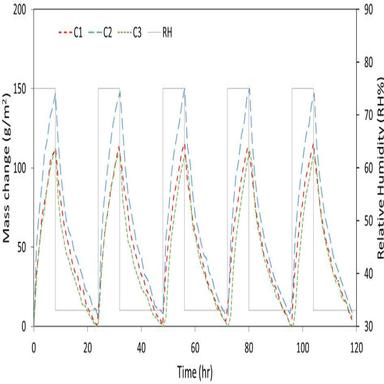
Mass change of the composites when exposed to varying relative humidity at 23 C.